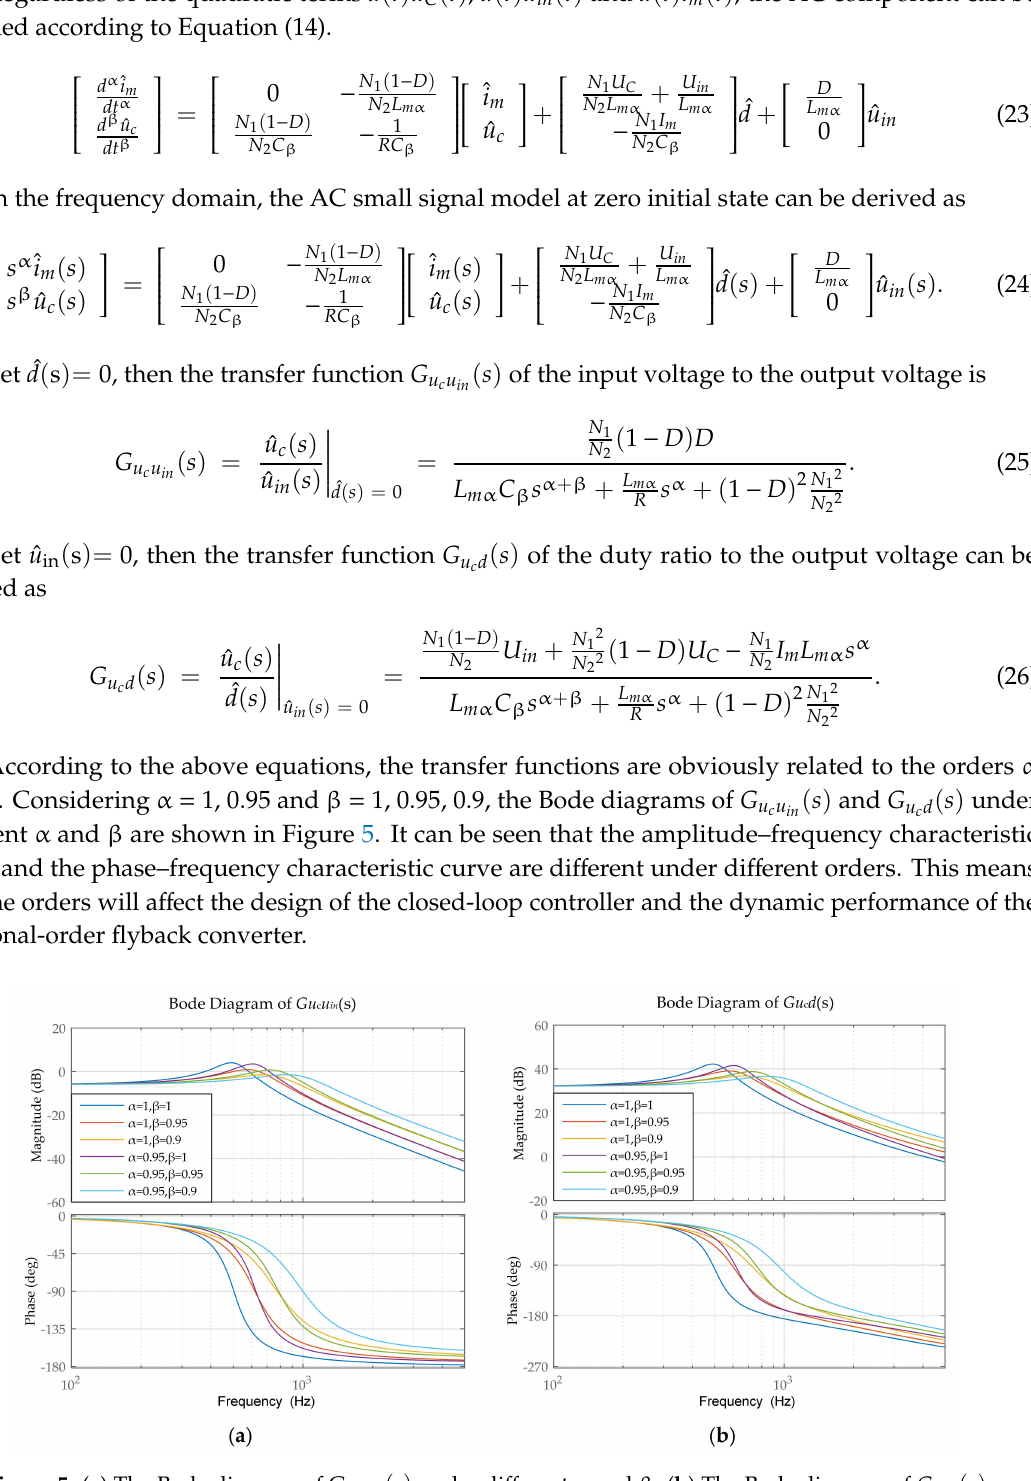
Figure 5. ( a ) The Bode diagram of G u under di ff erent α and β